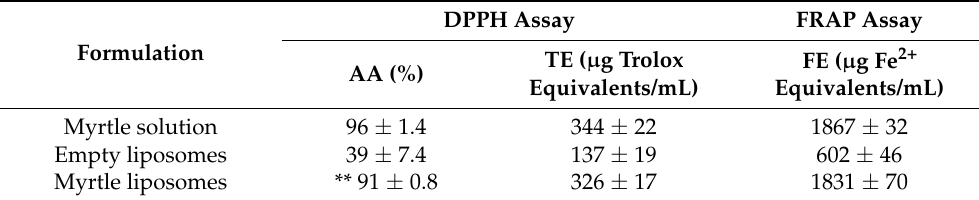
Table 4. In vitro antioxidant activity of myrtle formulations. For the DPPH assay, results are expressed as AA (%) and TE ( µ g Trolox equivalents/mL solution); for the FRAP assay, results are expressed as FE ( µ g Fe 2+ equivalents/mL solution). Results are reported as the mean ± SD of at least three separate experiments, each performed in triplicate. ** Statistically different values ( p < 0.01) from the myrtle